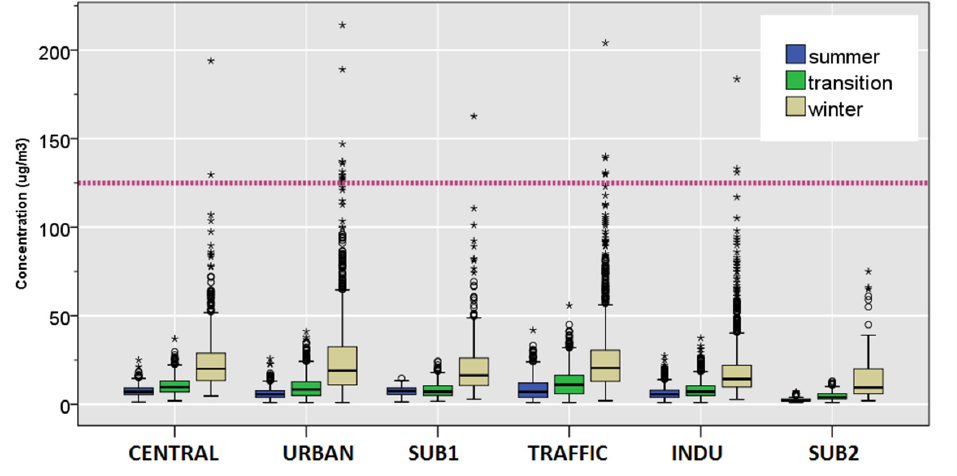
Figure 4. Distributions of daily concentrations SO 2 by season. The dotted line shows the EU standard of 125 µg/m 3 for SO 2 .